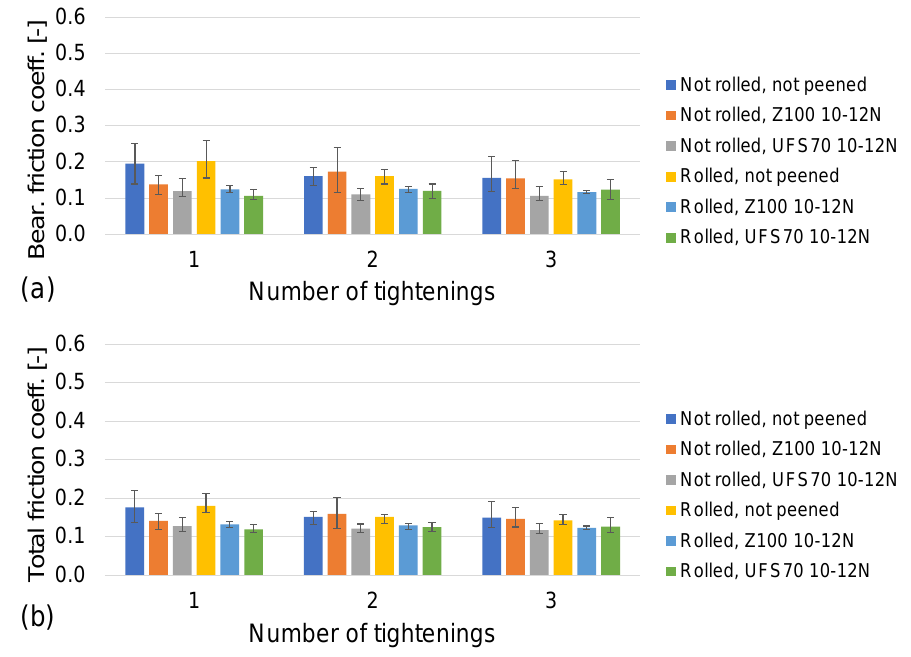
Figure 5. ( a ) Bearing and ( b ) total friction coefficients retrieved during the tests in grease lubricated conditions.